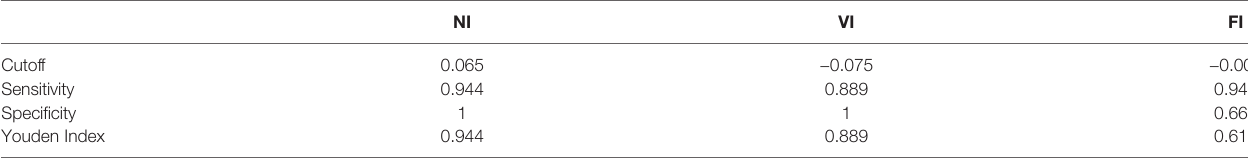
TABLE 4 | Respective cutoff values of deduced DTT metrics and statistical analysis. NI VI FI Cutoff